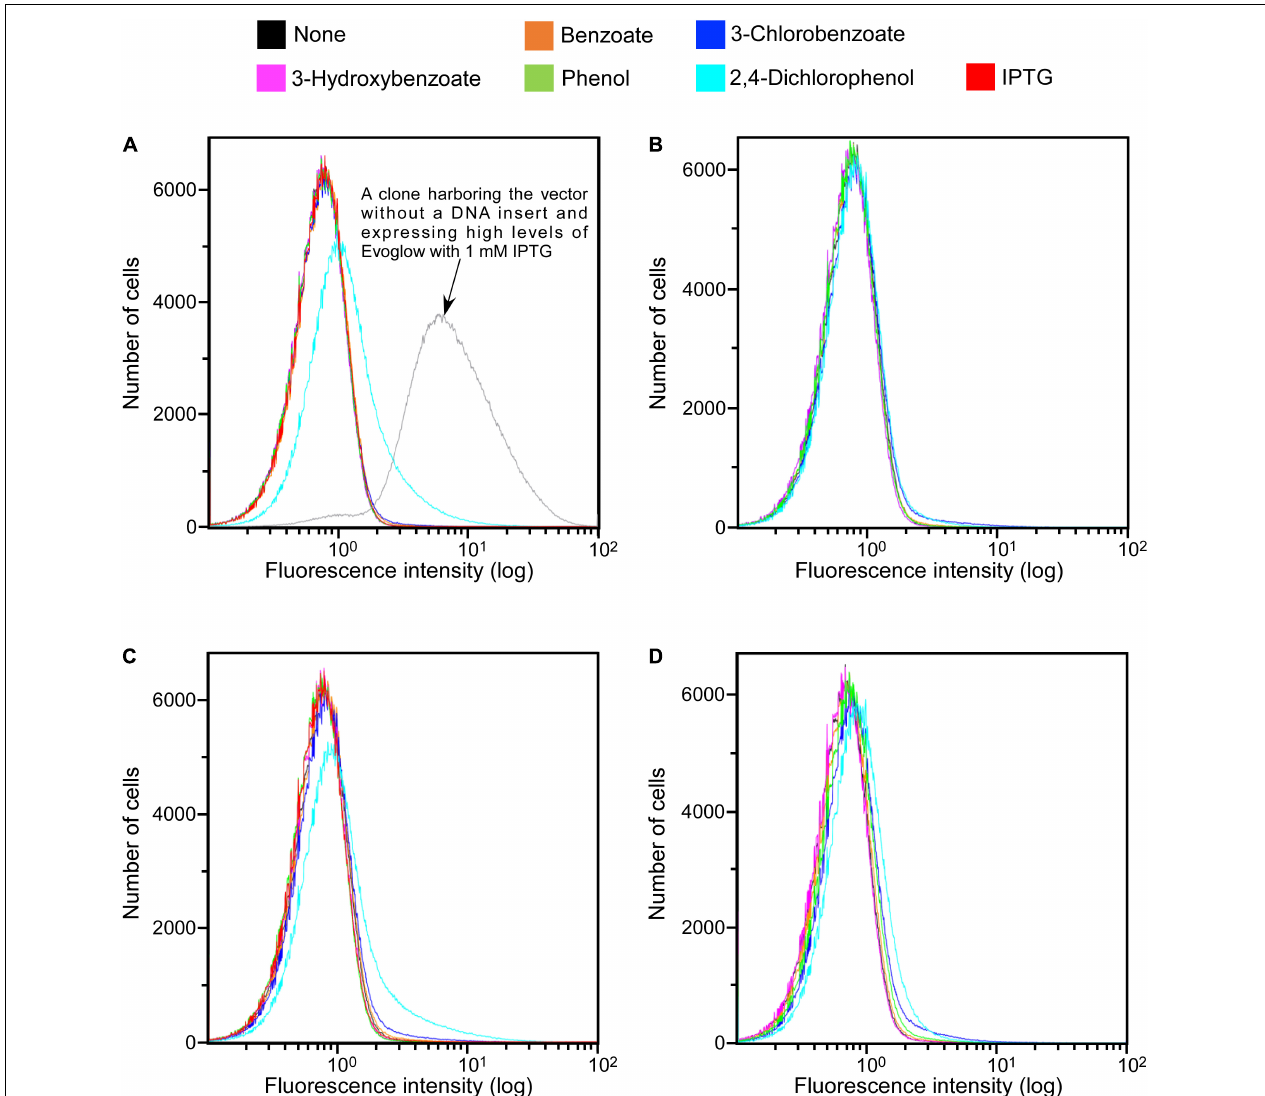
FIGURE 2 | SIGEX library expression histograms of Evoglow. Histograms of fluorescence of 1.00 × 10 6 cells were obtained using Gallios flow cytometer after cell exposure to the indicated compounds. The fluorescence intensity (log) was displayed up to 1.00 × 10 2 . (A) KY11-E06_0–5 library (aerobic conditions); (B) KY11-E06_0–5 library (anaerobic conditions); (C) NT13-15_0–10 library (aerobic conditions); (D) NT13-15_0–10 library (anaerobic